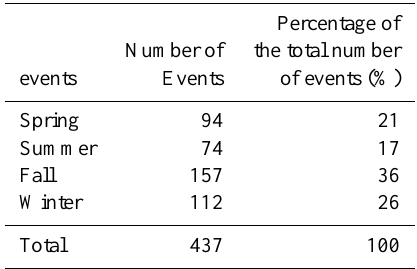
Table 2. Number of flood events selected for each season.